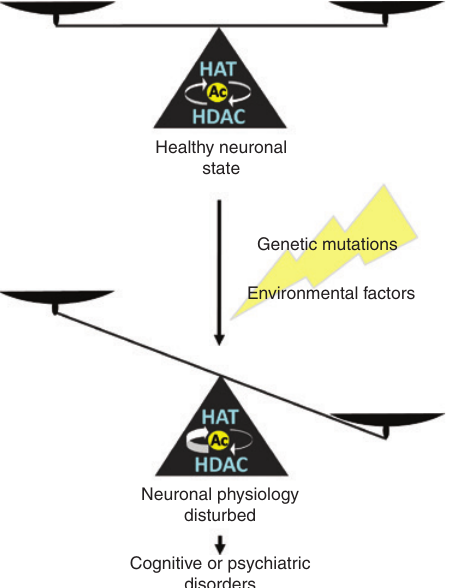
Figure 2: Role of the HAT/HDAC equilibrium in neuronal functions. In steady-state conditions, a proper balance in HAT/HDAC activities allows physiological histone acetylation, ensuring normal neuronal functions. When the HAT/HDAC balance is dysregulated (due to genetic or environmental causes), impaired histone acetylation leads to neuronal dysfunctions, with behavioral and cognitive